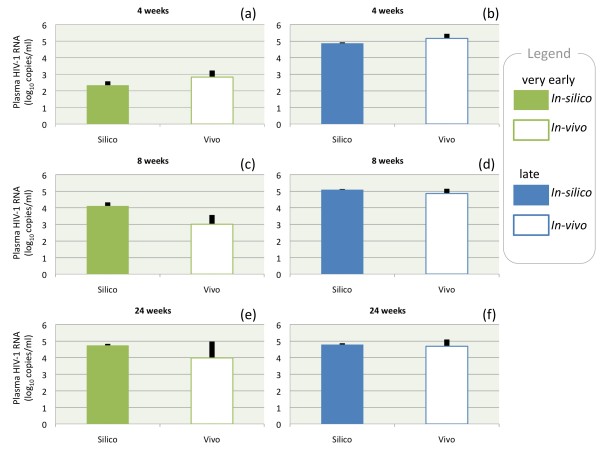
Virological rebound. Virological rebound after 4 weeks (top), 8 weeks (middle) and 24 weeks (bottom) from therapy interruption for two groups: very early (green boxes) that started HAART before seroconversion and late (blue boxes) that started HAART during chronic phase of primary HIV-1 infection. Filled boxes represent in silico data (resulting from three thousands runs) whereas empty boxes correspond to in vivo data. We have calculated the Mann-Whitney U test statistics for assessing whether the two independent samples (in silico and in vivo) come from the same distribution. In all cases we did not find a significant difference (P ≥ 0.05, Mann-Whitney U two-tailed test). Black lines indicate standard deviations. Information on parameter settings for the simulations can be found in the Additional file 1.